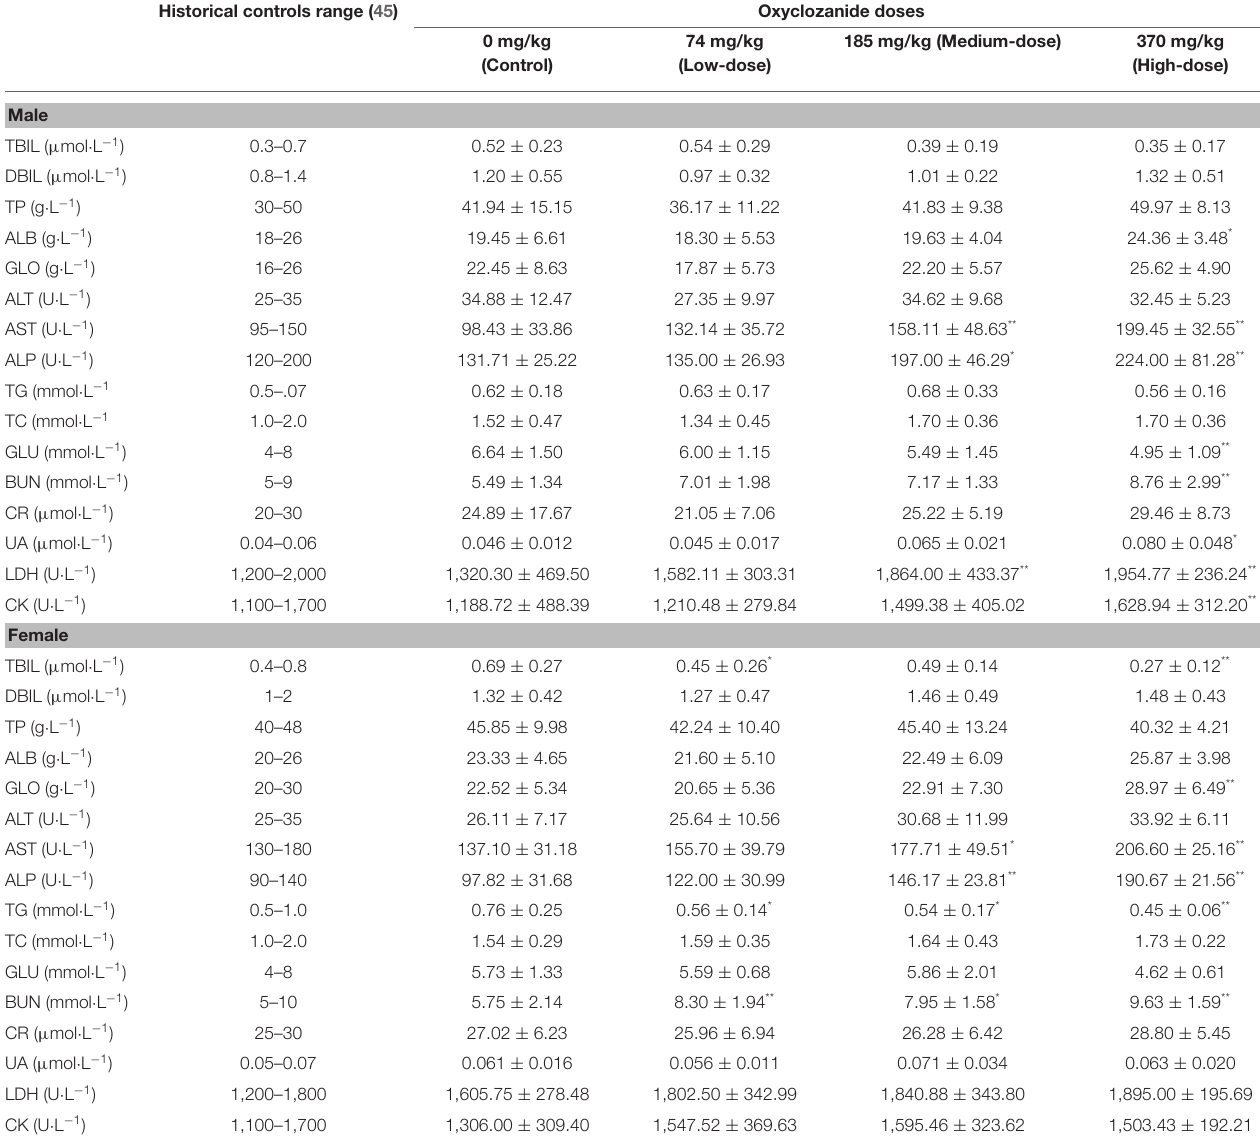
TABLE 3 | Liver function related to biochemical